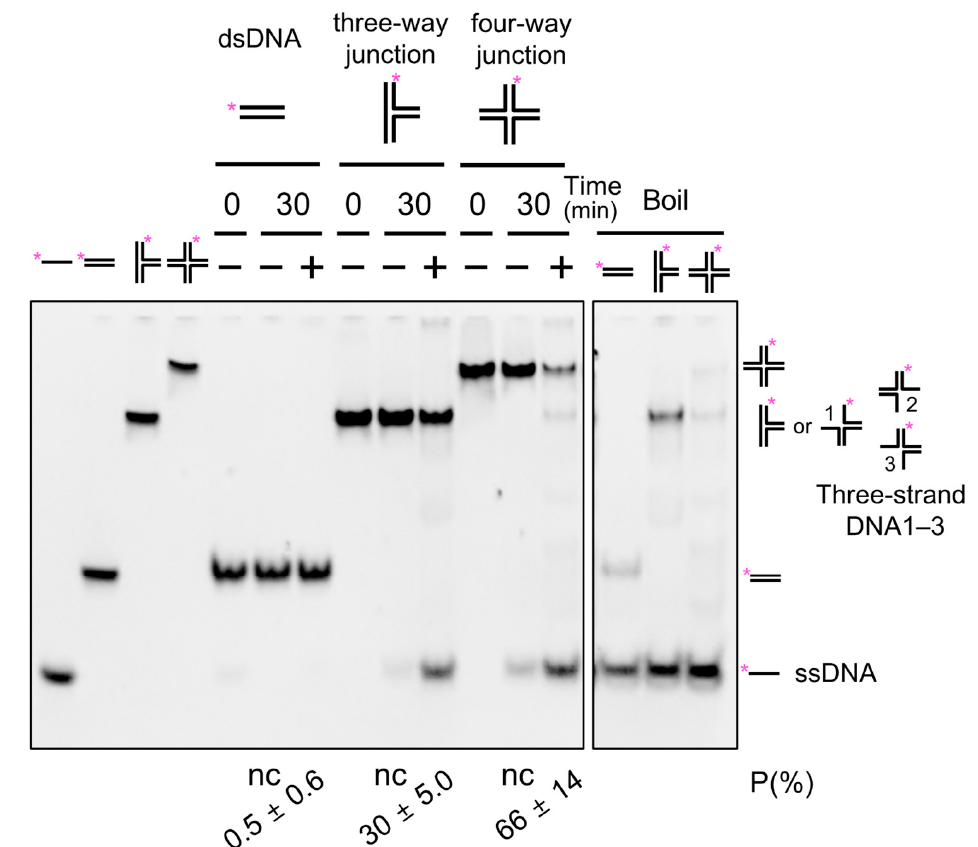
Figure 5. Helicase activity of Sac aLhr1 for branched DNA molecules. dsDNA, three-way junction (Y-junction2), and four-way junction (HJS) (10 nM) were incubated with (+) or without ( − ) Sac aLhr1 (123 nM) at 70 °C for 30 min. Reactions were performed without trap DNA. Asterisks represent 5 ′ -DyLight 5 labels. “Boil” indicates boiling of the substrate at 98 °C for 3 min followed by cooling on ice water. Detected bands were assigned using the controls of each shaped DNA on the right side of the panel. Reactions were quantified by measuring the band intensities and expressed as P% (product per total DNA) and are indicated under each lane. Value from each negative control reaction without protein (nc, negative control) was subtracted from each value. Data are presented as mean ± SD, calculated from values of three independent experiments.